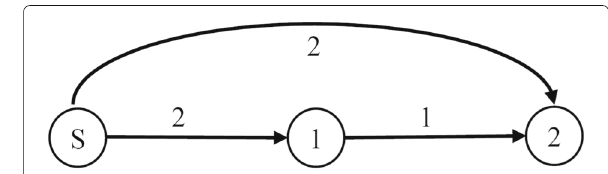
Fig. 3 An example: one directed